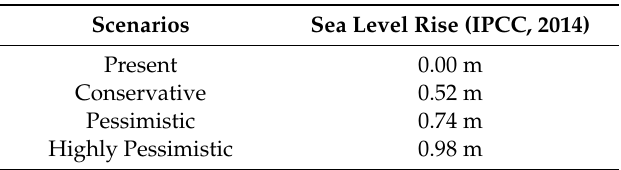
Table 2. Mean values of the Intergovernmental Panel on Climate Change (IPCC) SLR prospected for the next 100 years to best- and worst-case